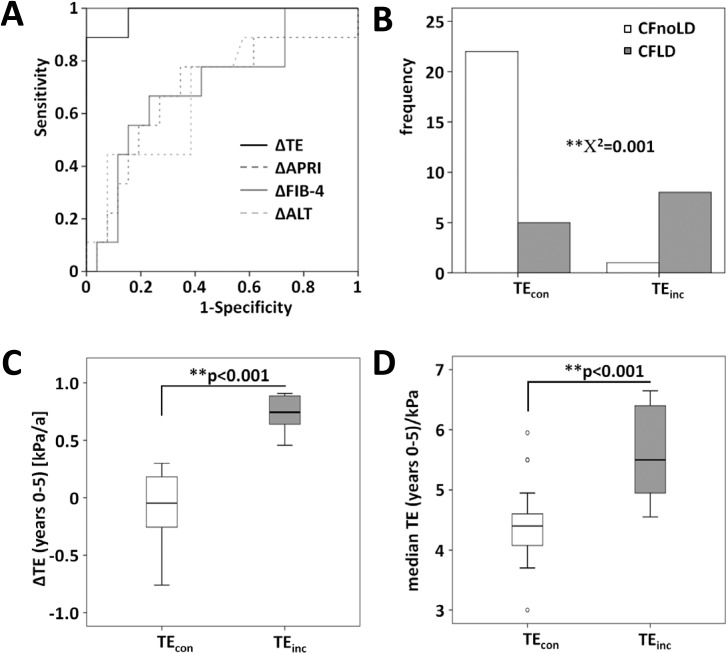
The increase in liver stiffness (ΔTE) defines the development of CFLD in pediatric patients.(A) The receiver operating characteristics (ROC) analysis identified a consistent increase of liver stiffness in 9 of 10 pediatric patients with a TE(4–5) >6.3 kPa and fixed the cut-off as rationale for grouping ΔTEcut-off = 0.38 kPa/year. The frequency of CFLD (B), the enhancement of liver stiffness ΔTE (C), and the median stiffness (D) was increased in the TEinc-group compared to the TEcon-group.